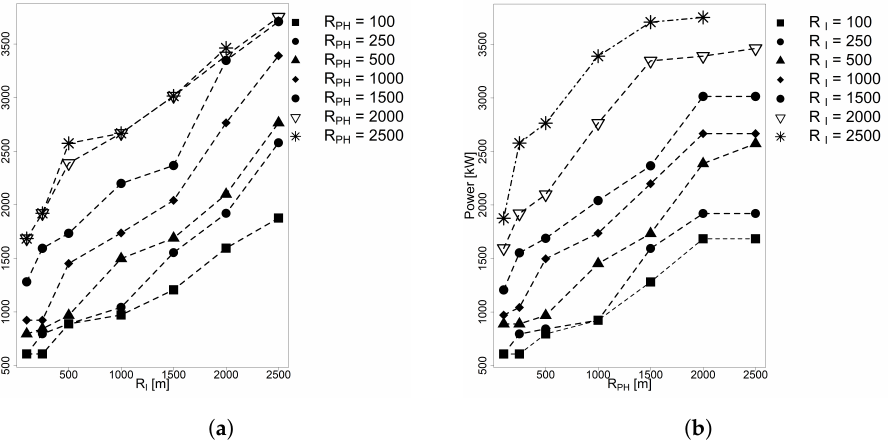
Figure 12. Power as function of R I and R PH for maximum HP values. ( a ) Fixed R PH value ( b ) Fixed R I